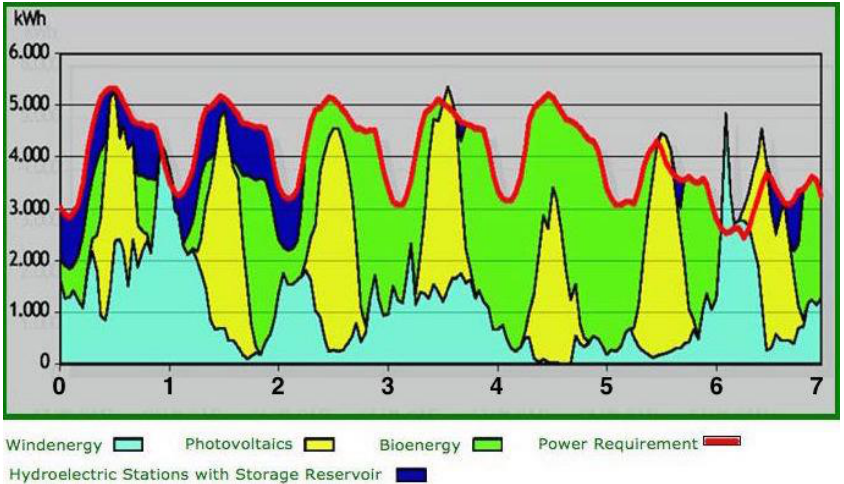
Figure 7. As renewable energy systems proliferate and diversify, the grid will stabilize by blending diverse sources. Simulated mixture of sources in one week [22].